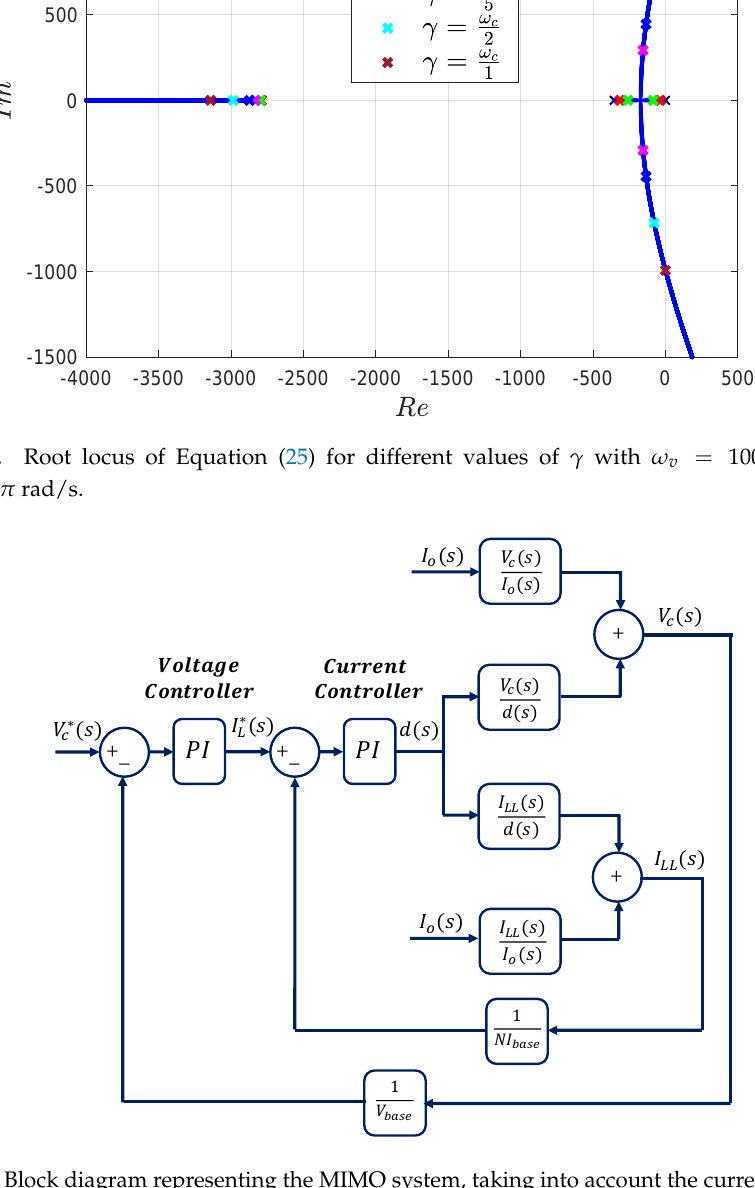
Figure 11. Block diagram representing the MIMO system, taking into account the current and voltage controllers’